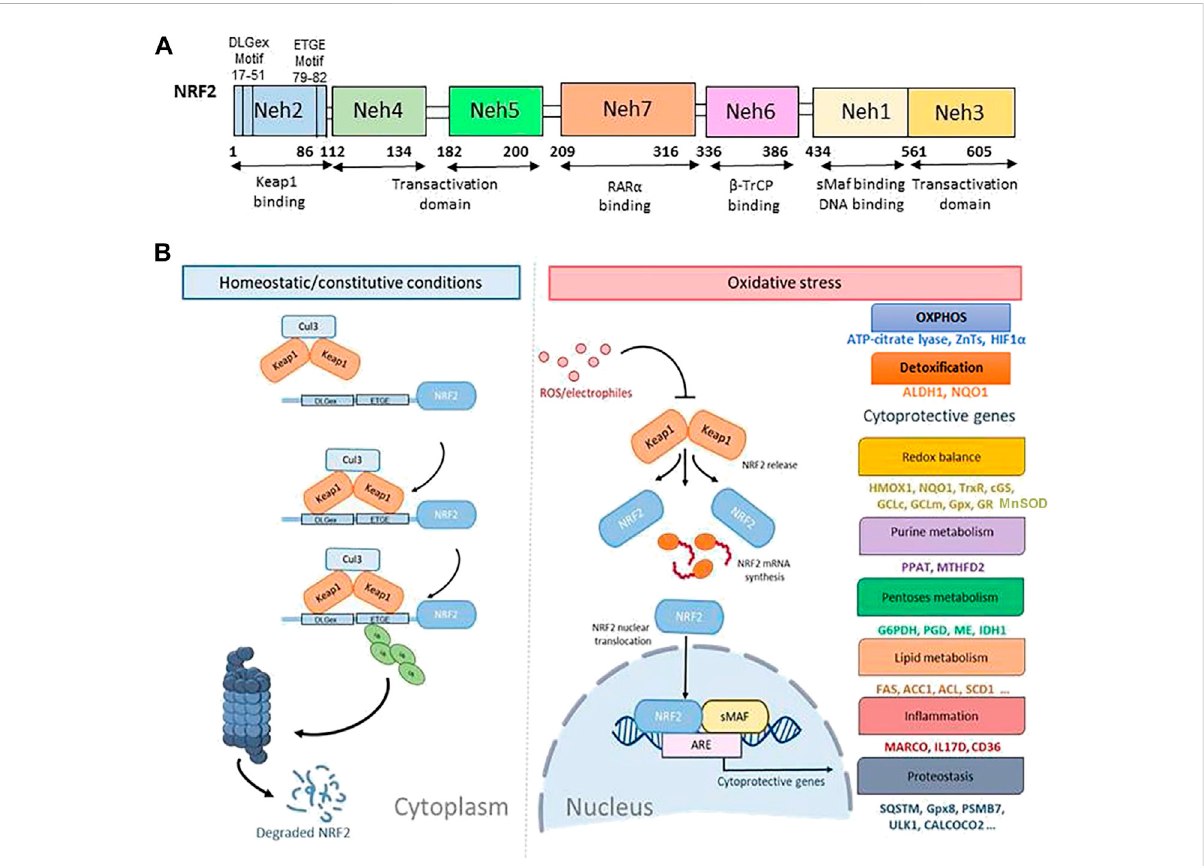
FIGURE 1 The canonical regulatory pathways of NRF2 signaling. (A) . Domain structure of NRF2 (NF-E2-related factor 2), member of the Cap ’ n ’ collar (CNC) transcription factor family, consists of 605 amino acids organized in seven highly conserved functional domains, known as Neh1-Neh7. (B) . Under homeostatic/constitutive conditions, a continuous degradation of NRF2 protein in the cytoplasm is achieved, through the formation of a complex of involving E3 ubiquitin ligase containing the regulatory cysteine rich Keap1 protein. Binding of the Keap1 homodimer is mediated by the two NRF2 sequences, ETGE and DLGex, located in the Neh2 domain, which leads to its ubiquitylation and proteasomal degradation. When Keap1ischallengedwithROSorelectrophiles,criticalcysteinesaremodi fi ed,anon-functionalKEAP1complexisgenerated,andNRF2degradationis blocked. Thus, de-novo synthesized NRF2 is stabilized and imported to the nucleus where it activates the ARE-mediated transcription of cytoprotective